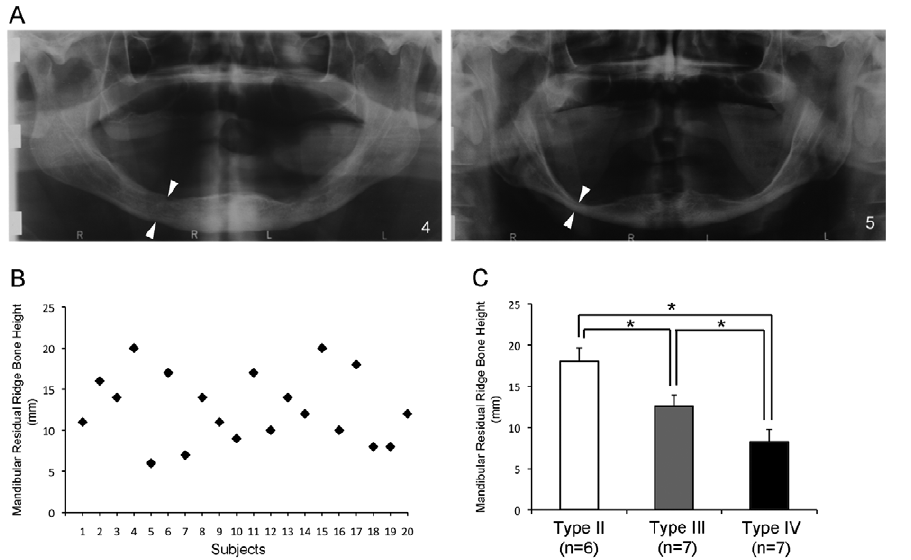
Figure 2. Characterization of mandibular edentulous ridge. A . Panoramic dental radiographs were used to determine the lowest residual ridge height (arrowheads) of edentulous mandible. Severe atrophy of edentulous mandible was observed in Subject # 5 (right). B . Scatter plot of mandibular residual ridge heights indicated a uniform distribution between 6 to 20 mm. C . All subjects fell into one of the following ACP classifications: Type II (n=6); Type III (n=7); and Type IV (n=7). Type II indicates mildly resorbed residual ridge, whereas Types III and IV are considered severely resorbed residual ridges. *P , 0.05 by Student’s t-test